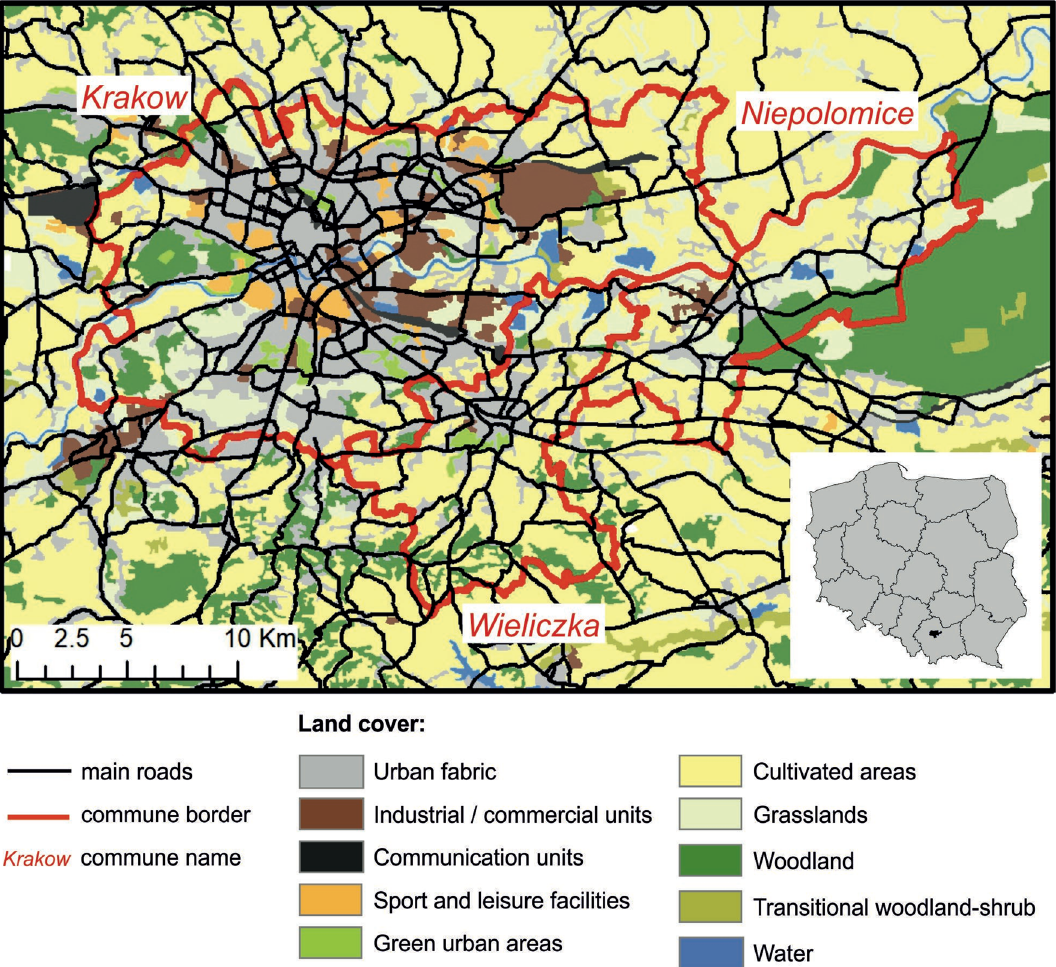
Figure 6. Land cover map of the study area. Land cover information was derived from the CORINE Land Cover 2018 (https:// land. coper nicus. eu/ pan- europ ean/ corine- land- cover), and road layer shows all the primary, secondary and tertiary roads from the OpenStreetMap. The figure in the bottom right corner shows location of the study area in Poland.